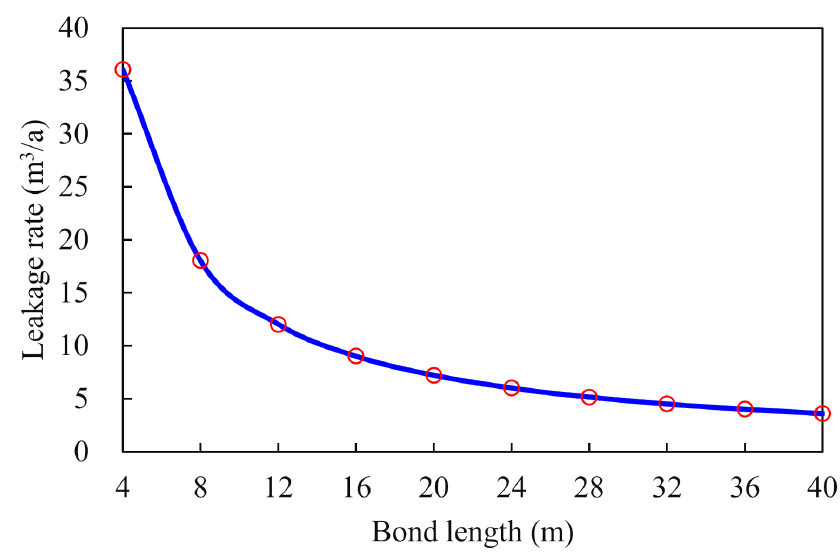
Figure 9. The influence of the effective bonding length of cement sheath on the leakage rate. As the viscosity of fluid in the formation increased, the leakage rate decreased rapidly and then gradually slowed down (Figure 10). Viscosity had a comparable effect on the leakage rate as bonding length. Viscosity negatively correlated with the leakage rate, which reduced from 7.2 to 0.9 m 3 /a as the viscosity was increased from 0.01 to 0.08 mPa · s. Natural gas contains more impurities under formation conditions [29]. The heterogeneity of the gas caused high viscosity, which decelerated the leakage.